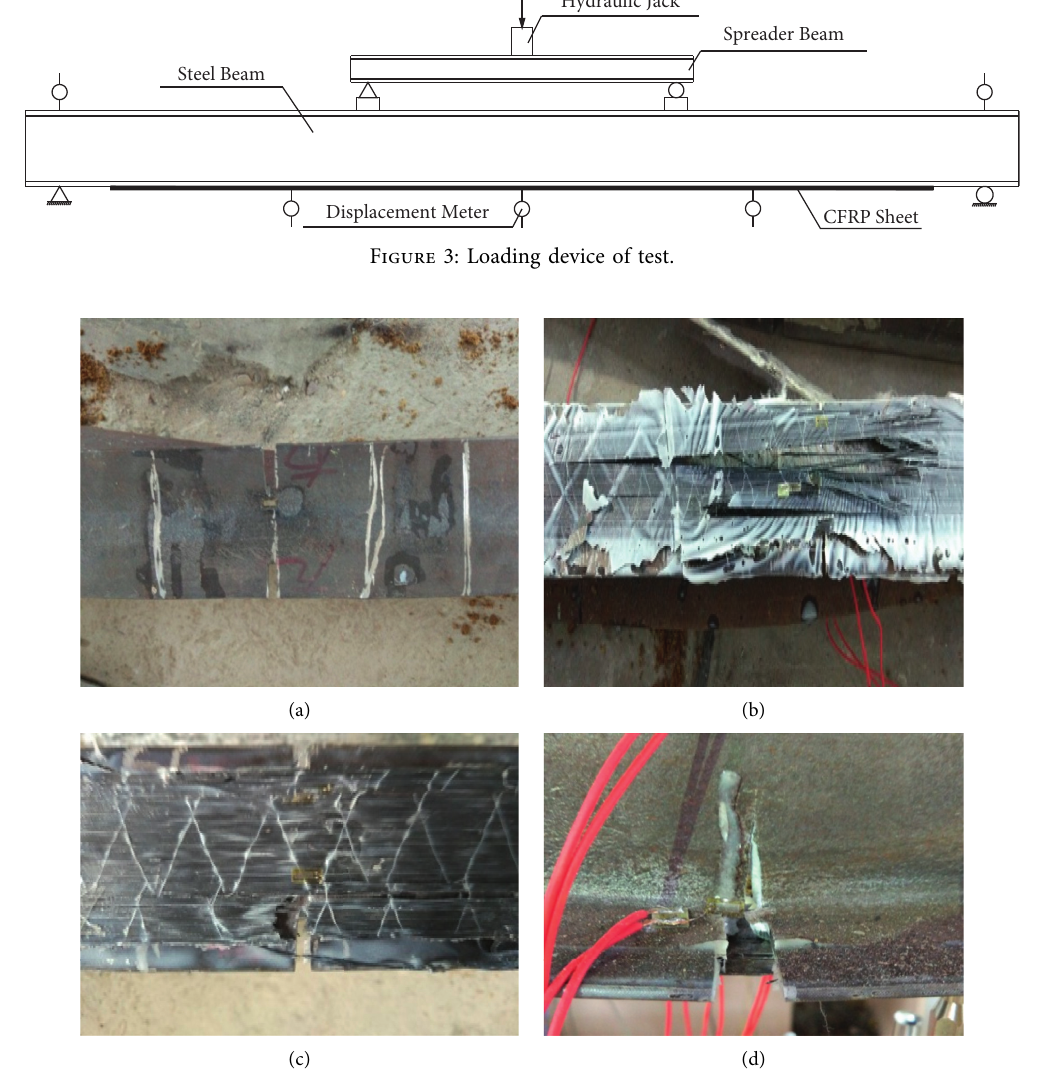
Figure 4: Failure modes of test specimens. (a) SB0. (b) CFSB1. (c) CFSB2. (d) CFSB3.